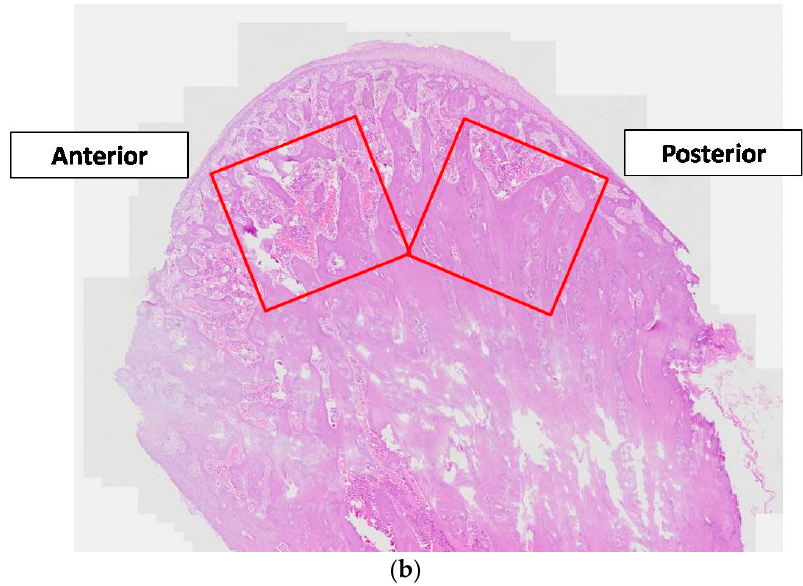
Figure 4. Histological images of the sagittal sections of the condyle ( a ). Condylar cartilage thickness measurements (anterior, middle, and posterior). ( b ). Square condylar head regions of interest (anterior and posterior), measuring 1.0 × 1.0 mm (H&E staining, original magnification ×20).